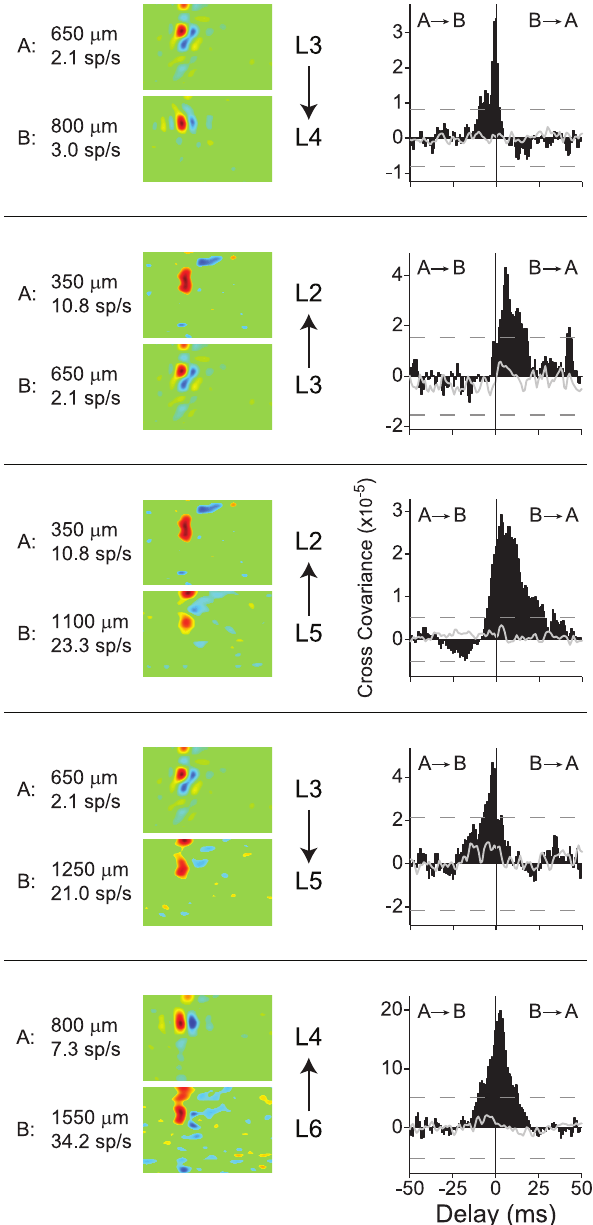
Figure 2. Example STRFs and temporal interactions between neurons in an AI column. Data are from the example penetration shown in Fig. 1. Each row represents a separate pair of neurons. (Left) Depth, firing rate, and STRF of the neurons for which cross-covariance functions were computed. Layer assignments are to the right of the STRFs (L2-L6). (Right) Cross-covariance functions for the pairs of neurons in the left column. Arrows indicate direction of the temporal interaction: negative delays mean A fired before B, positive delays mean B fired before A. Dashed lines indicate 99% confidence intervals. Gray curves indicate shift predictors, i.e., the timing distribution of non- simultaneously recorded spike trains. The laminar connection patterns most consistent which the cross-covariance function are shown to the right of the each STRF pair.